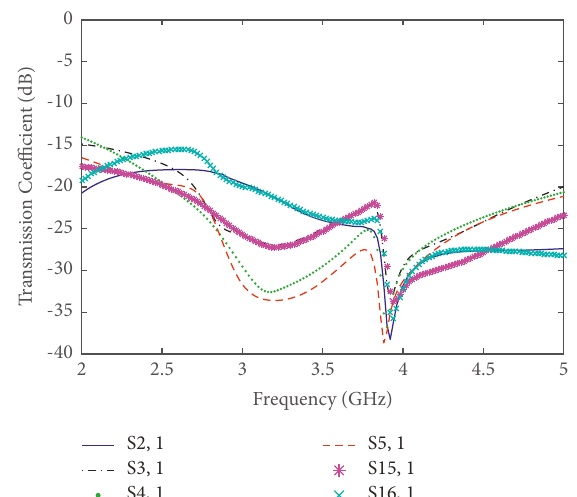
Figure 16: Scattering matrix of 16 PLPA elements around double-tumor phantom: S2, 1-S3, 1-S4, 1-S5, 1-S15, 1-S16, and